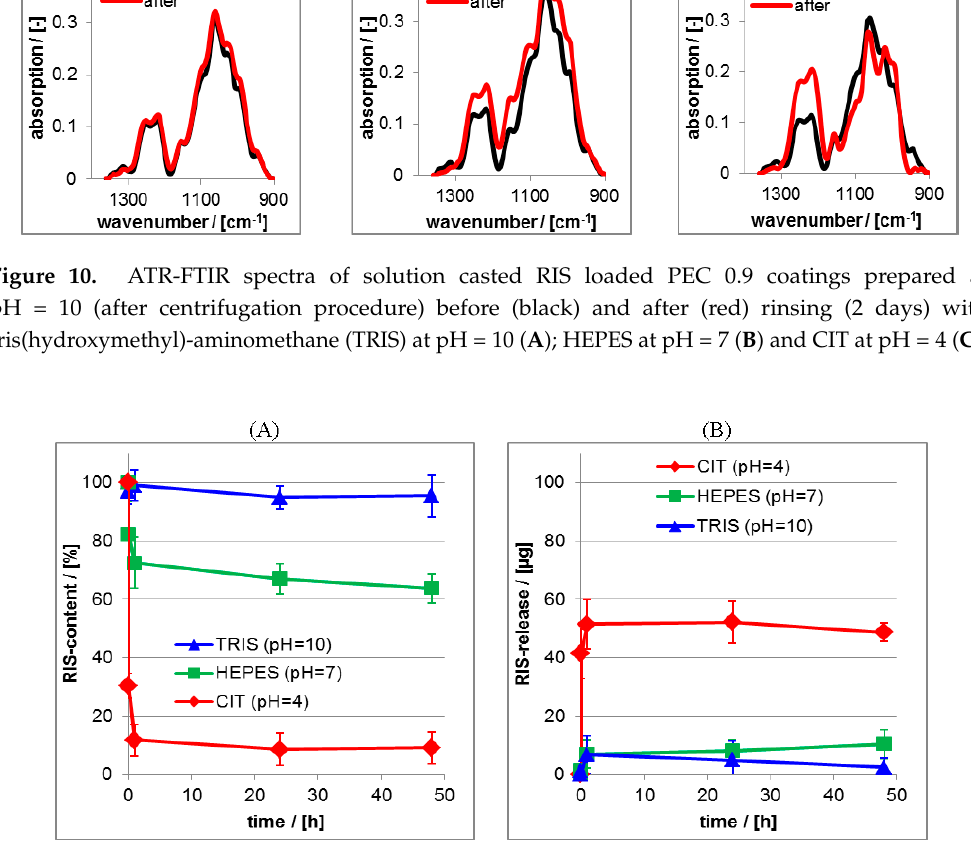
Figure 11. ( A ) Release kinetics from RIS/PEC films at aqueous release media for pH = 4, pH = 7 and pH = 10. (ATR-FTIR data); ( B ) Release kinetics from RIS/PEC films at aqueous release media for pH = 4, pH = 7 and pH = 10. (UV/VIS data).